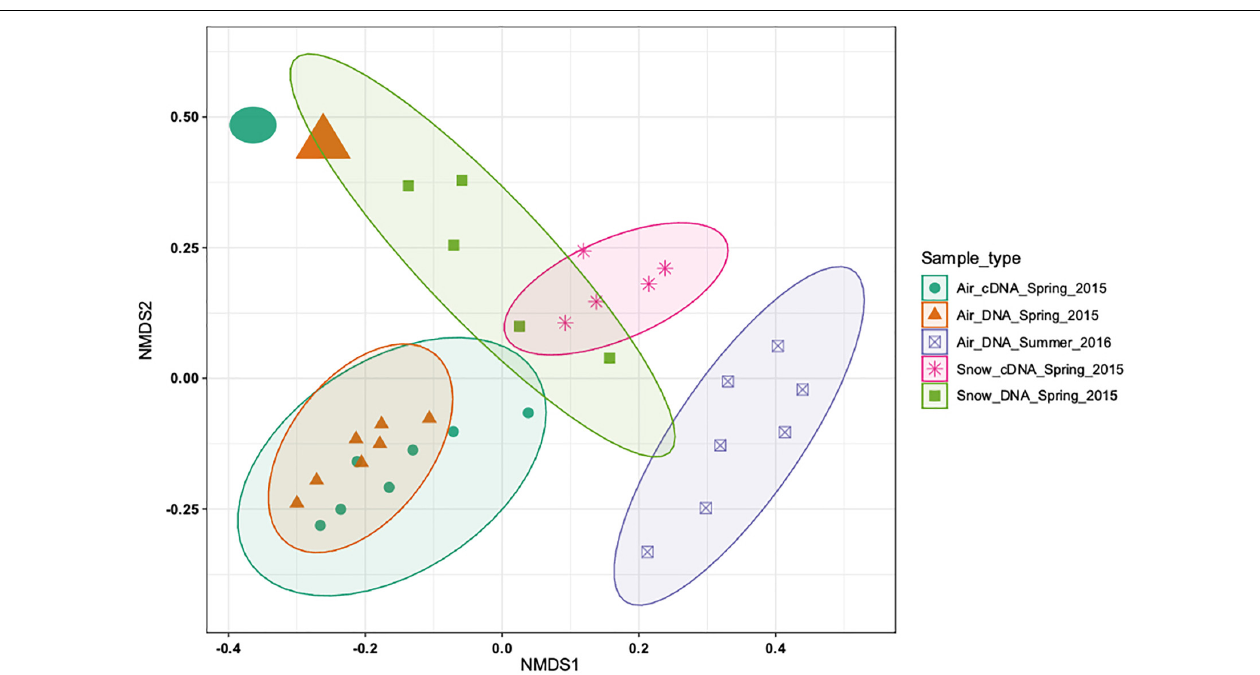
FIGURE 2 | Non-metric multidimensional scaling (NMDS) based on the Bray-Curtis distance measure of 33 samples from 5 sample types of 2988 ASVs. No initial data transformation has been applied. The DNA-level air and snow bacterial communities sampled in spring and summer are shown and how close they cluster together. While most of the samples from the different sample types cluster closely together two samples (top left corner, sampled on the day of the snowstorm) cluster more closely with the snow samples than the other air samples.